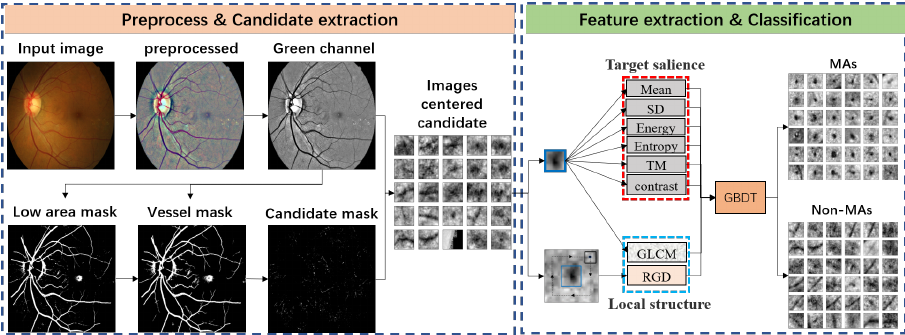
Figure 2. Schematic diagram of the automatic MA detection method, including preprocessing, candidate extraction, feature extraction, and classification.